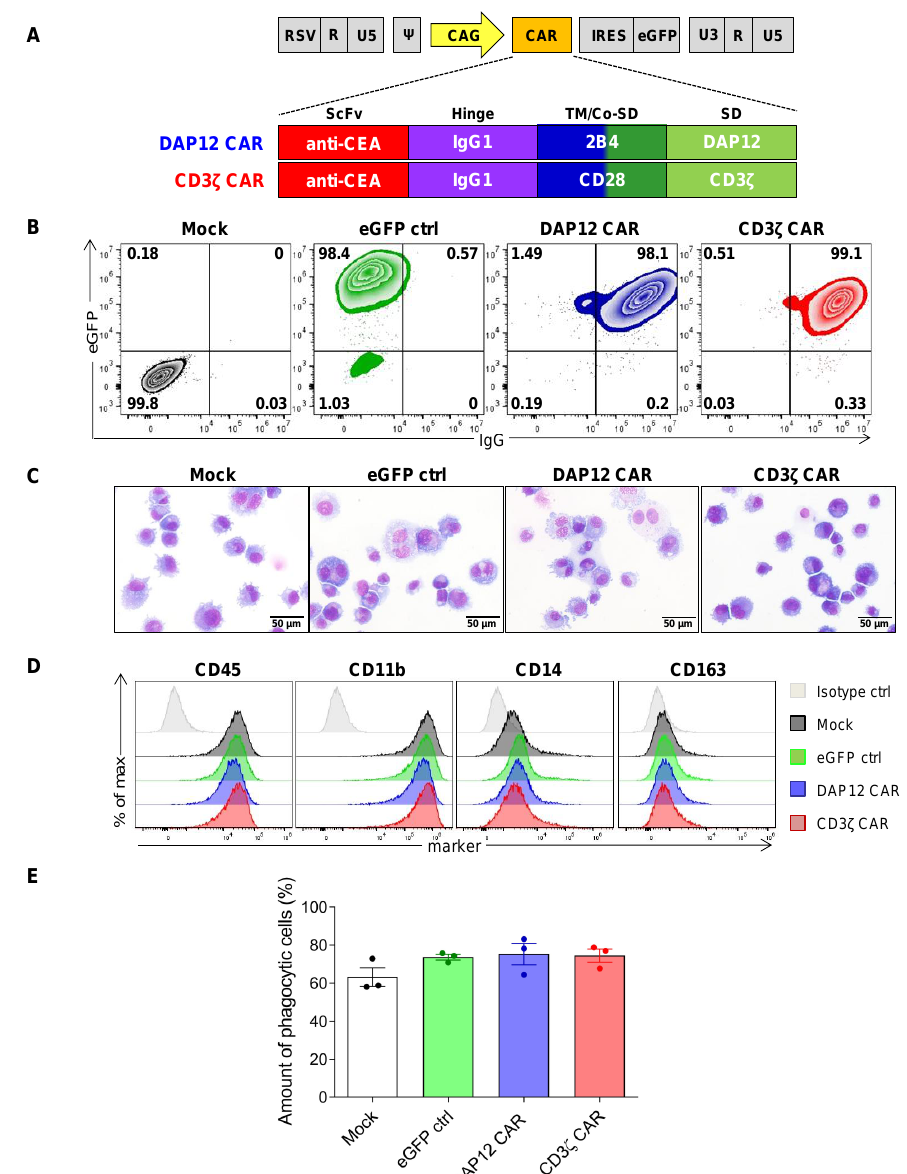
Figure 1. Expression of anti-CEA CARs in differentiated CAR THP-1 cells. ( A ) Scheme depicting the structure of both anti-CEA CARs. ( B ) Flow cytometric analyses of eGFP and CAR expression in differentiated THP-1 cells. Controls included mock-transduced THP-1 cells (Mock) and THP-1 cells transduced with a lentiviral vector designed to express eGFP alone (eGFP ctrl). Plots are shown for a representative out of 3 experiments. ( C ) Microscopic analyses of THP-1 cell morphology using May–Grünwald-stained cytospins (40 × magnification using the fluorescence microscope Olympus IX71, scale bar: 50 µ M). ( D ) Flow cytometric analyses of surface markers on differentiated THP-1 cells. Data are representative out of 2 experiments. ( E ) Analysis of phagocytic activity of E. coli particles in THP-1 cells as revealed by flow cytometry. Median phagocytosis percentages with standard deviations are shown ( n = 3). scFv: single chain variable fragment; TM: transmembrane domain; Co-SD: costimulatory signaling domain; IgG: human IgG1 CH2CH3; ctrl: